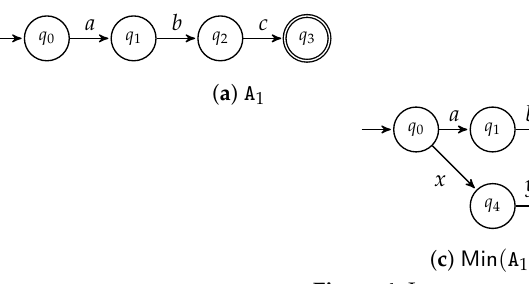
Figure 4. Least upper bound of D FA / ≡